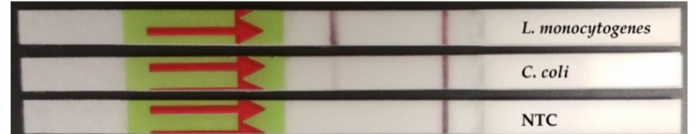
Figure 2. Lateral flow strips showing the di ff erence in the intensity of the test band with a specific ( L. monocytogenes ) and non-specific ( C. coli ) detection obtained with RPA amplification, using PCR primers. NTC: non-template